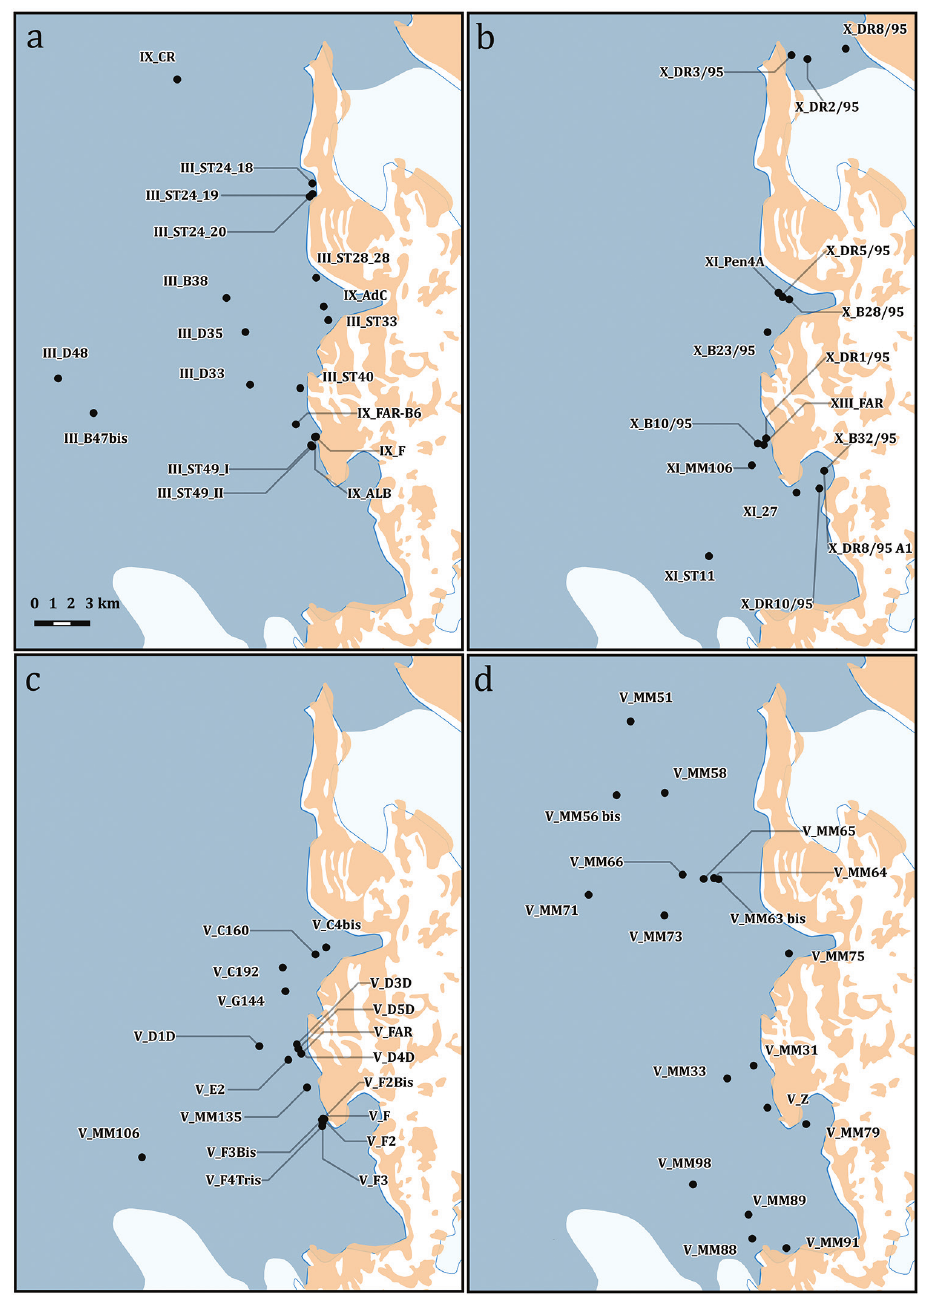
Figure 4. Detailed map of the sampling stations of the PNRA expeditions III, V, IX, X, XI,